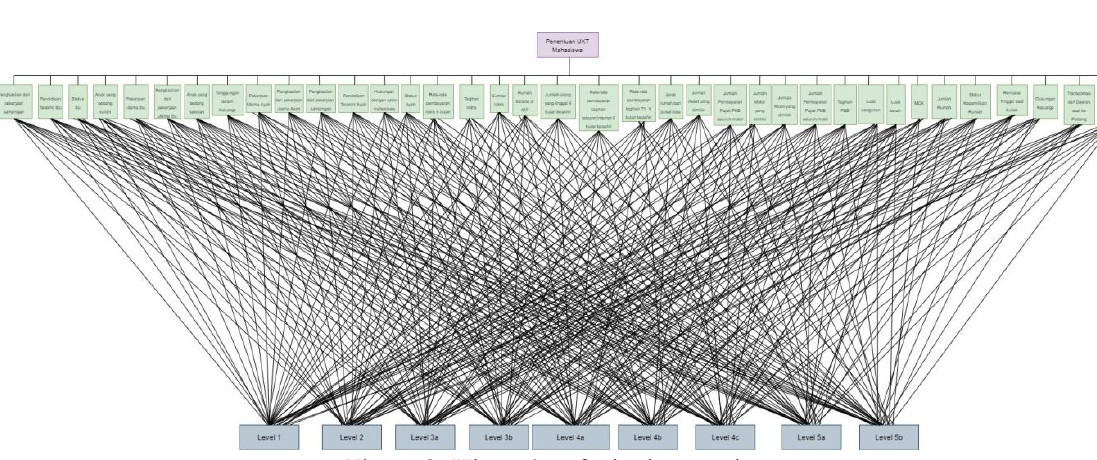
Figure 2. Hierarchy of criteria grouping